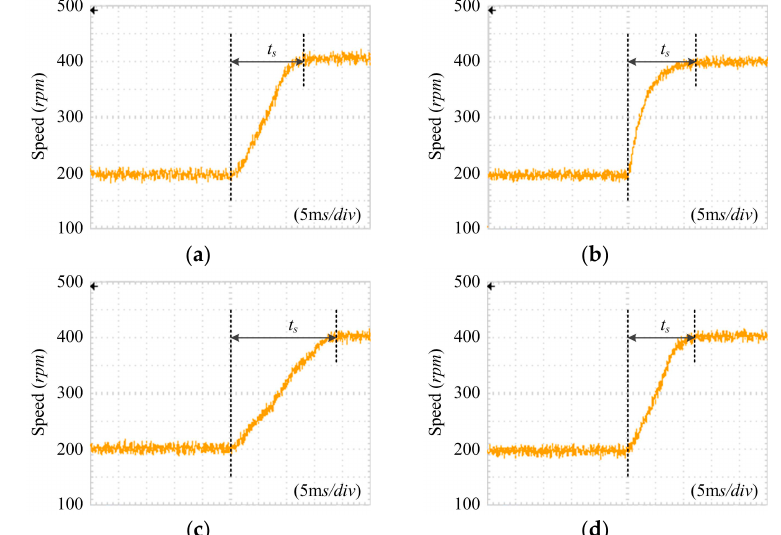
Figure 12. The speed trajectory from 200 rpm to 400 rpm when using: ( a ) conventional DTC (CDTC); ( b ) duty ratio direct torque control (DDTC); ( c ) space vector modulation DTC (SVM-DTC); ( d ) CVM-DTC.